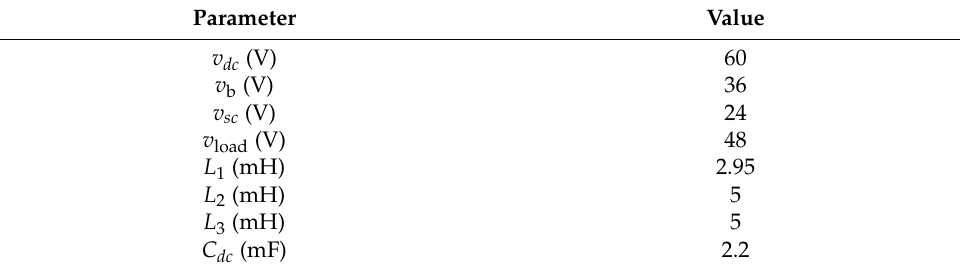
Table 5. Parameters of experimental platform.